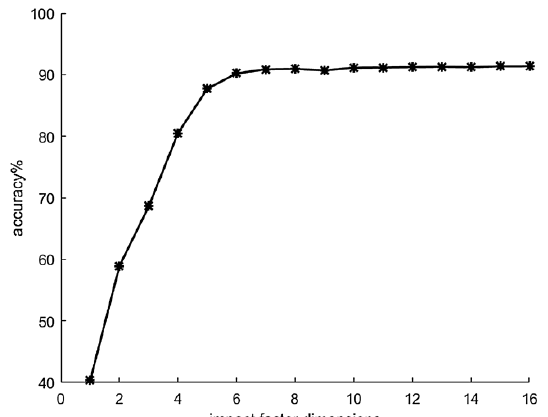
Figure 8. Contribution rate of impact factor.